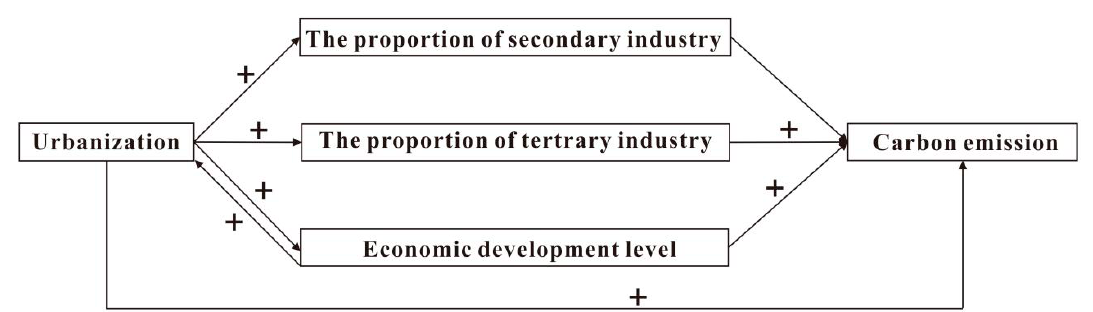
Figure 4. The significant impact path of urbanization on carbon emissions.